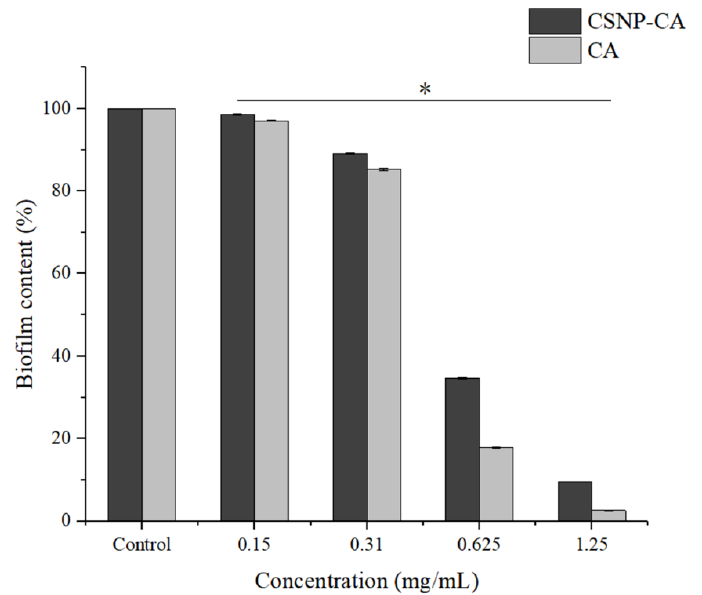
Figure 3. Inhibition effects of NPs on biofilm in 96-well microplates. The results represent the means and standard deviations (error bars) of three independent experiments. * p < 0.05 for comparison between the untreated and treated groups.